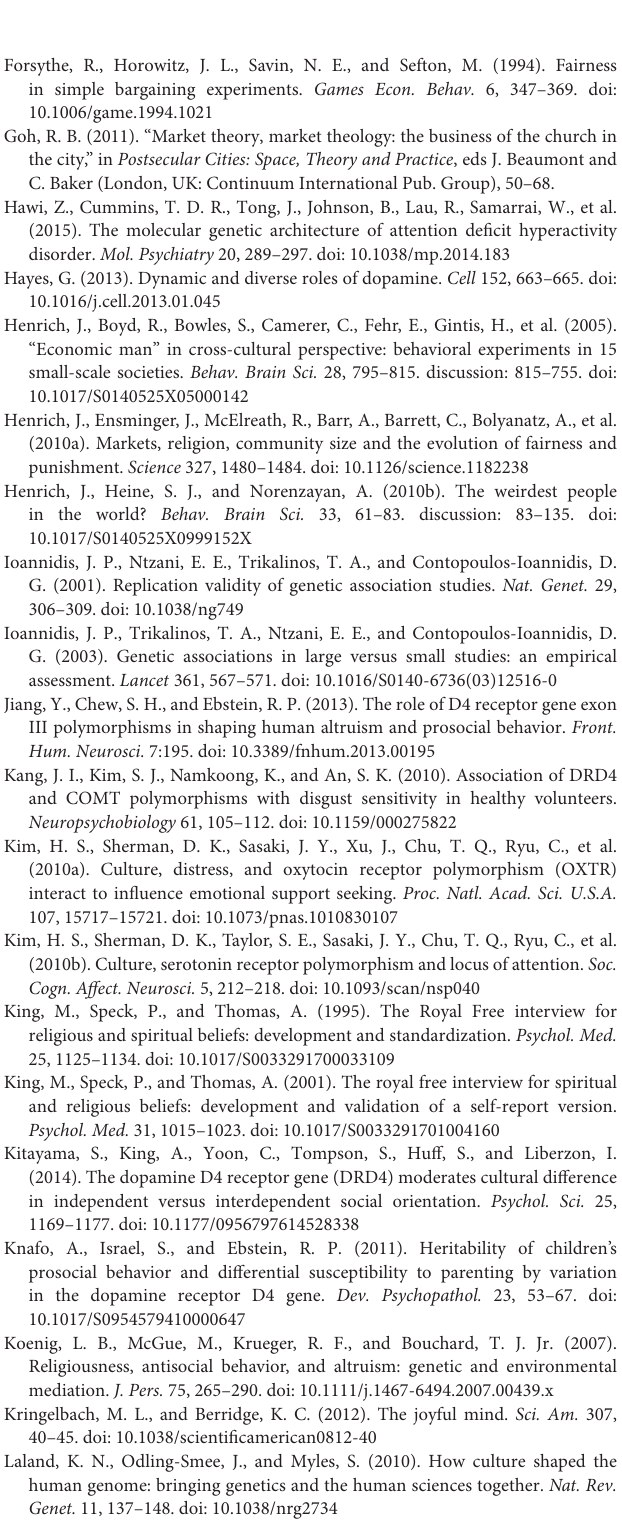
Figure S1 | Interaction effect of DRD4 and religious affiliation in Male subgroup. Mean comparison of deviations from archetypical behaviors between religious affiliations, stratified by DRD4 exon III genotype (only using data from males and not females, as similar pattern is not observed